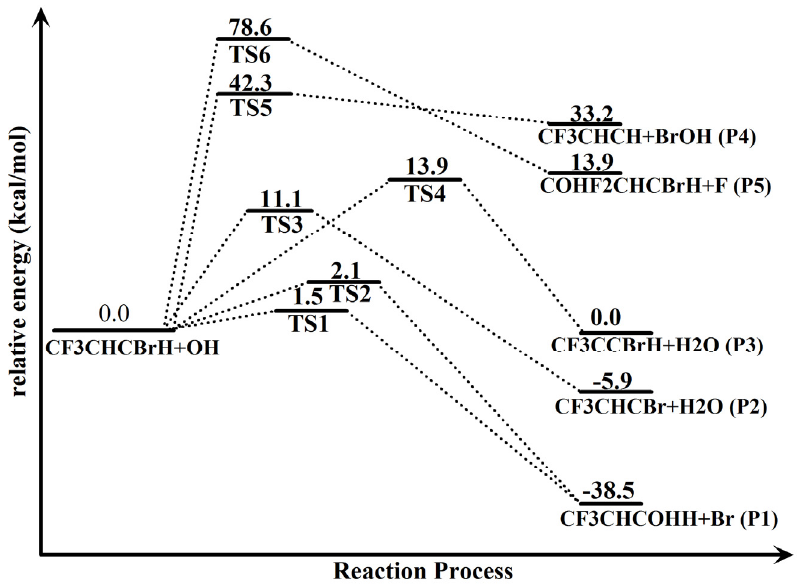
Figure 2. Potential energy surface for the reaction of trans-CF radical based on the relative energies obtained at the